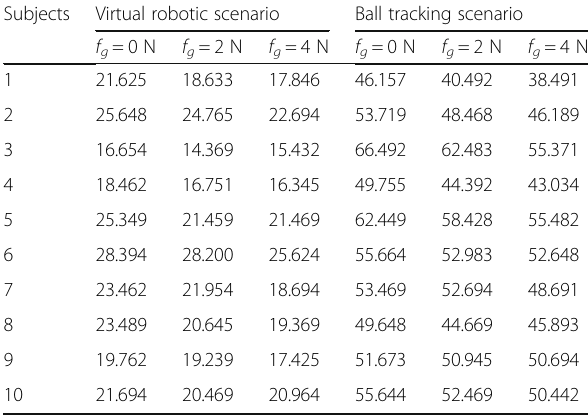
Table 1 Average Task Completion Time (Second) Subjects Virtual robotic scenario